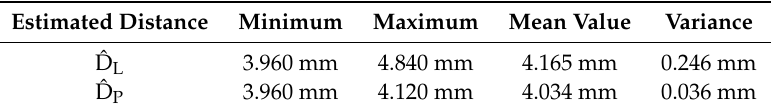
Figure 14. ( a ) ˆD x displayed by 3D map (the value of ˆD x is about − 2.1 mm at a low temperature, L L which indicates the large distance deviation of the LUT method); ( b ) ˆD x displayed by 3D map (the P value of ˆD x is close to zero mm at a low temperature, which shows that the proposed system can P decrease the deviation of the distance estimation); ( c ) ˆD x displayed by contour map ( ˆD xL is in the L range of [ − 2.1, 0.4] mm, the large negative value of which results in the blue color of the areas at a low temperature); ( d ) ˆD x displayed by contour map (the blue color of the areas at a low temperature in ( c ) P changes into green color in ( d ), which indicates that ∆ ˆD xP is closer to zero than ∆ ˆD xL ); ( e ) error map of ˆD ˆD x L (the error rate of the LUT method is 23.5%); ( f ) error map of x P (the error rate of our proposed method is 4.1%). Table 6. Comparison of the estimated distances when the target distance is 4 mm ( ˆD P are closer to 4 mm than ˆD L , and all the values of ˆD P are within the range of [3.8, 4.2] mm, which demonstrates that a more accurate sensing distance was obtained by the proposed